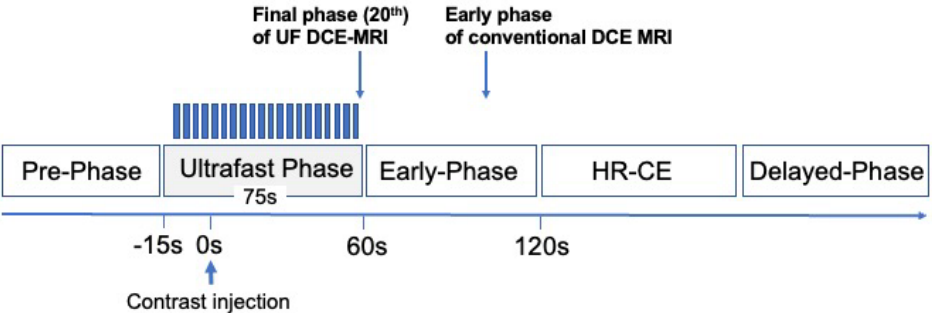
Figure 1. Flow diagram of the study population. UF DCE Ultrafast dynamic contrast-enhanced.